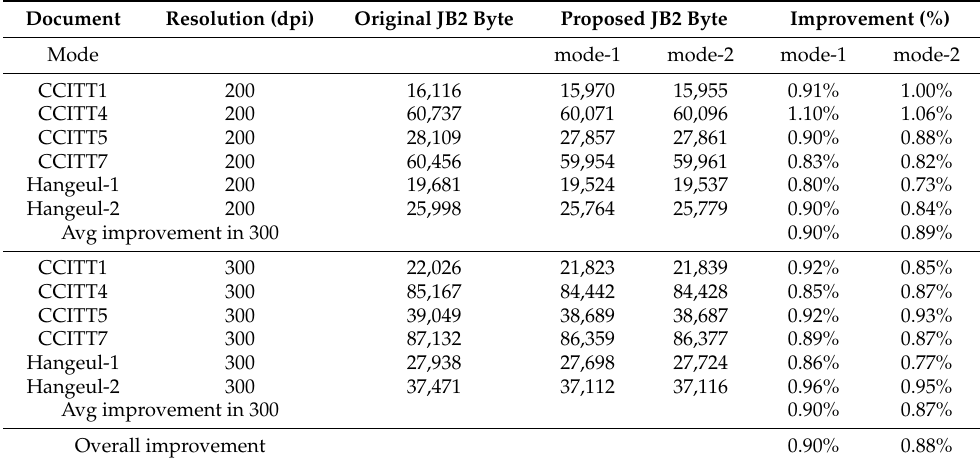
Table 16. 8-level LUT experimental results for JBIG2. ( α = β =